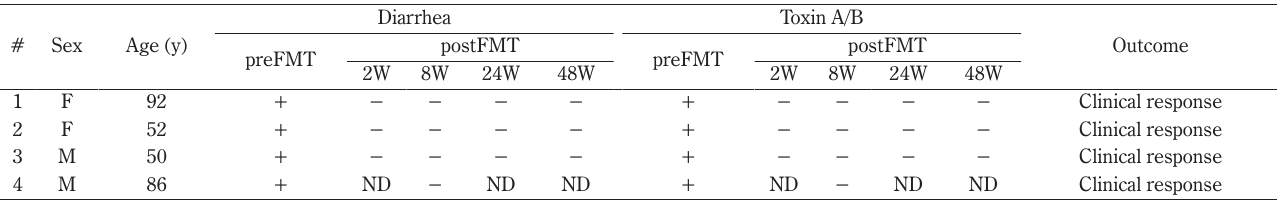
Table 3 Clinical characteristics and outcomes after fecal microbiota transplantation in patients with recurrent Clostridioides difficile